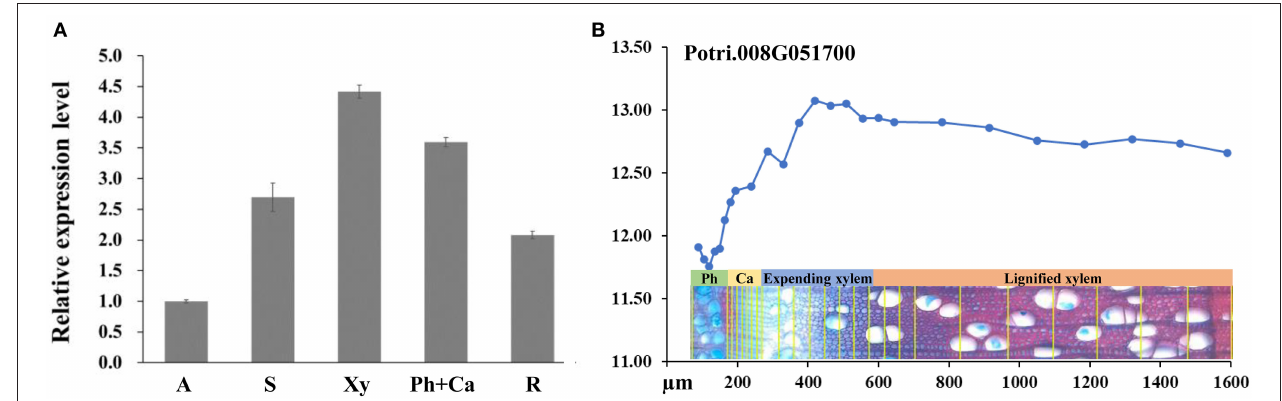
FIGURE 1 | Expression patterns of PagRabE1b in poplar. (A) Quantitative reverse transcription PCR (qRT-PCR) was carried out to analyze the gene expression levels of PagRabE1b indifferent tissues of poplar. The actin gene was used as an internal control. (B) Expression profiles of PagRabE1b among developing phloem, cambium, and developing xylem. Data were derived from the AspWood database (http://aspwood.popgenie.org) (Sundell et al., 2017). A, apex; S, stem; Xy, xylem; Ph, phloem; Ca, cambium; R, root.